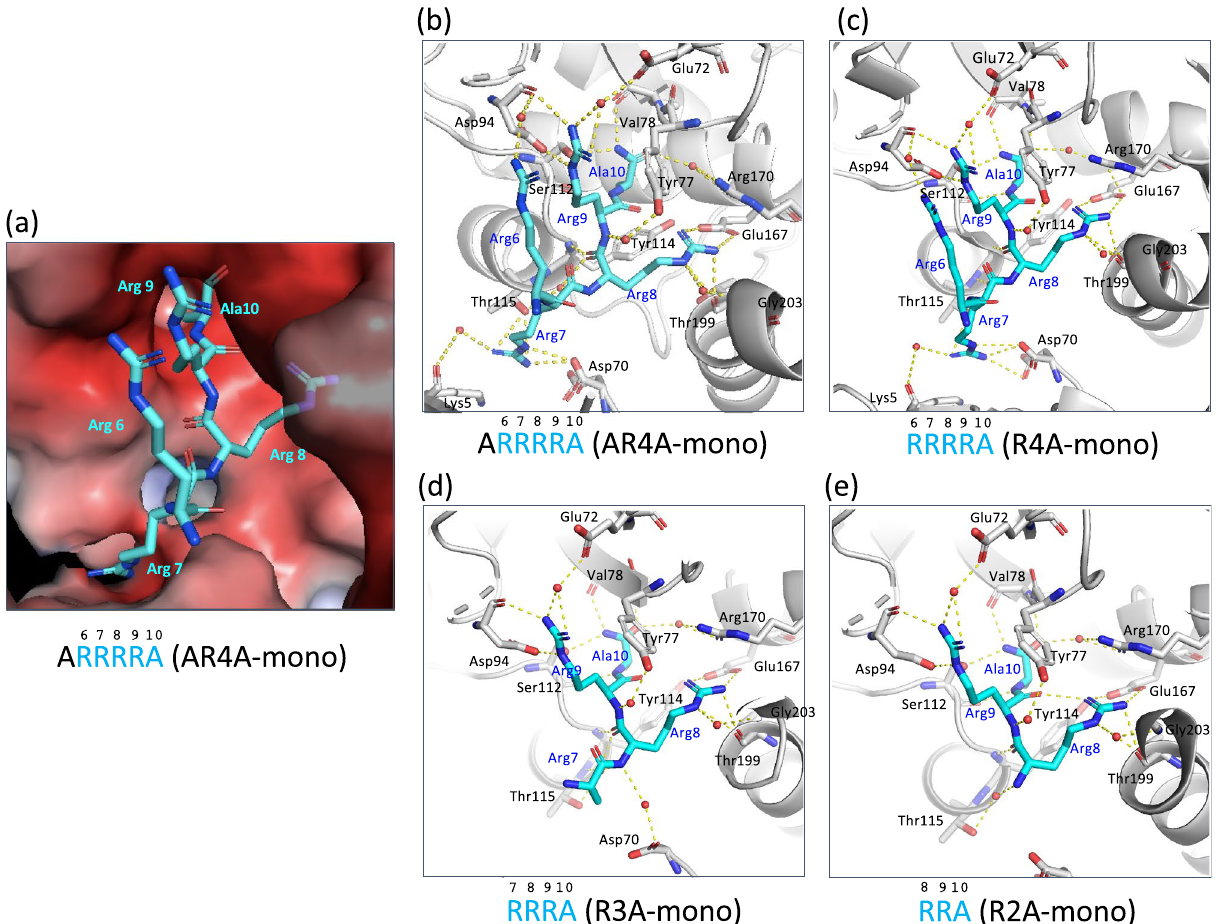
Figure 2. Structural analysis of the interaction between shorter MMβA-mono-derived peptides and the Stx2a A-subunit. ( a ) Close-up view of the Stx2a holotoxin in complex with AR4A-mono. Stx2a is shown as a charge distribution surface model, with the surface colored by charge (blue, positive; red, negative). AR4A-mono is shown as a stick model. ( b–e ) Structural view of binding between the A-subunit and shorter MMβA-mono- derived peptides ( b , AR4A-mono; c , R4A-mono; d , R3A-mono; and e, R2A-mono). In R3A-mono case, the electron density for the side chain of Arg7 was not determined (see also Supplementary Fig. S1). Interacting residues are shown as stick models, hydrogen bonds are shown as broken lines, and water molecules are shown as spheres. All crystal structure images were created using PyMOL ver. 2.3.4, (https:// pymol.